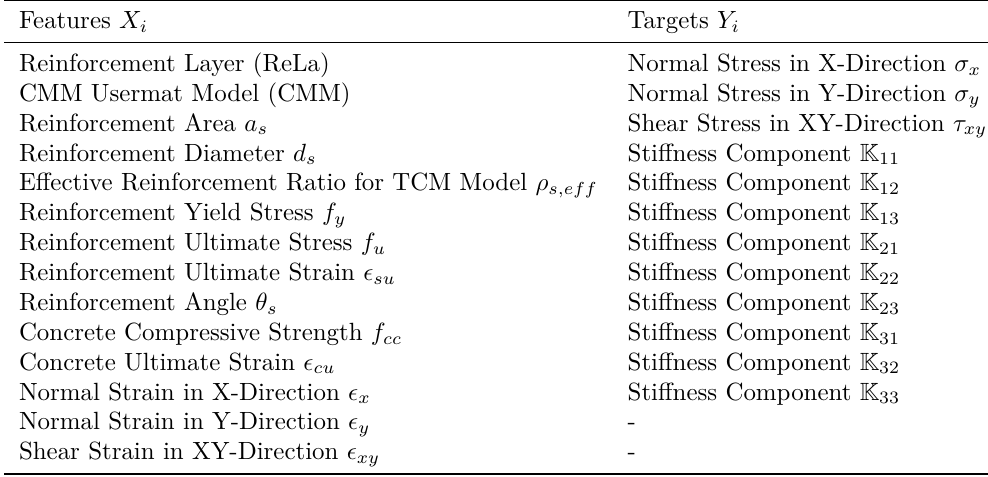
Table 1. List of Features and Targets for data generation and calibration of AI-FEM-Hybrids. Note that ϵ tensorial component of the shear strain γ